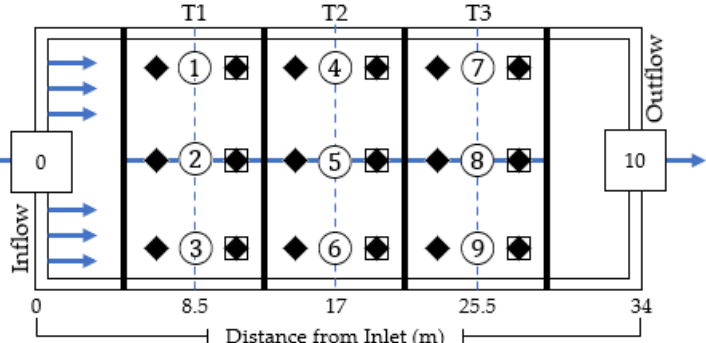
Figure 1. HF layout and experimental setup — black diamonds are bulk substrate sampling points; circles are piezometers, squares are aboveground biomass sampling points, and numbers are wastewater sampling points.